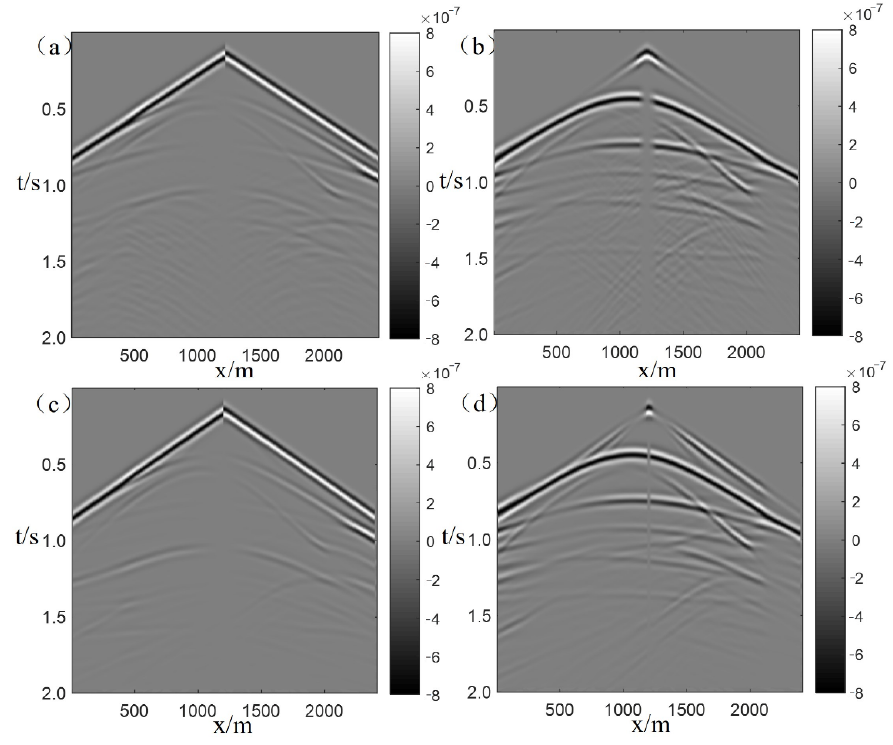
Figure 14. Shot record of fault model: ( a ) SGFD X component; ( b ) SGFD Z component; ( c ) 4th-order GFDM X component; ( d ) 4th-order GFDM Z component.